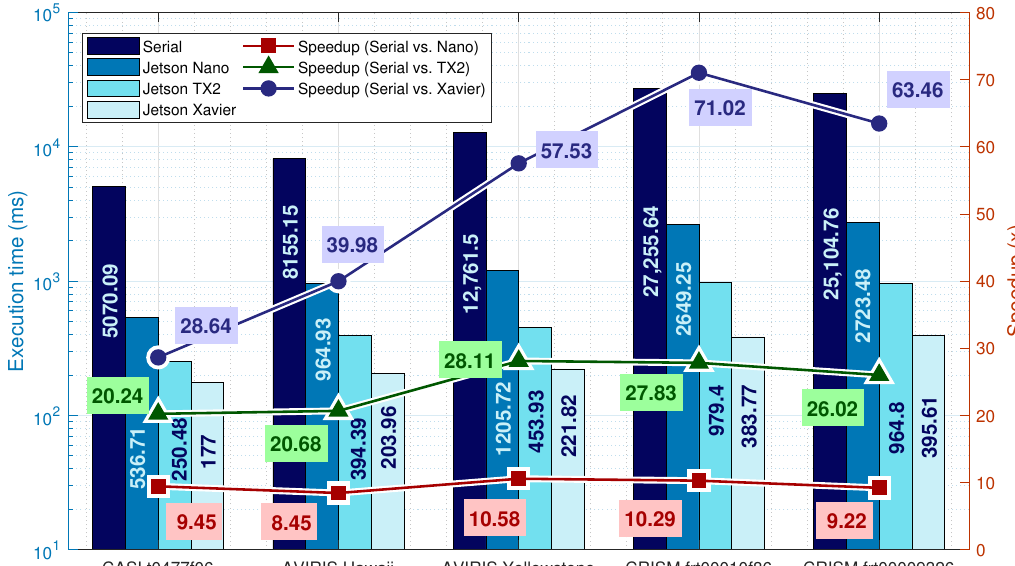
Figure 5. Parallel block adaptive entropy encoder speedups and total execution times. The bars represent the total execution time of the longest of the 3 methods, the worst-performing core of the bitstream generation and the bitstream concatenation time (see Figure 2). The lines represent speedup relative to serial execution time running in a single-core on the Nano platform (For the CRISM images, the Nano executes half of the bands for the predictor and both encoders due to memory restrictions. The presented values are multiplied by two to simulate the full image workload).